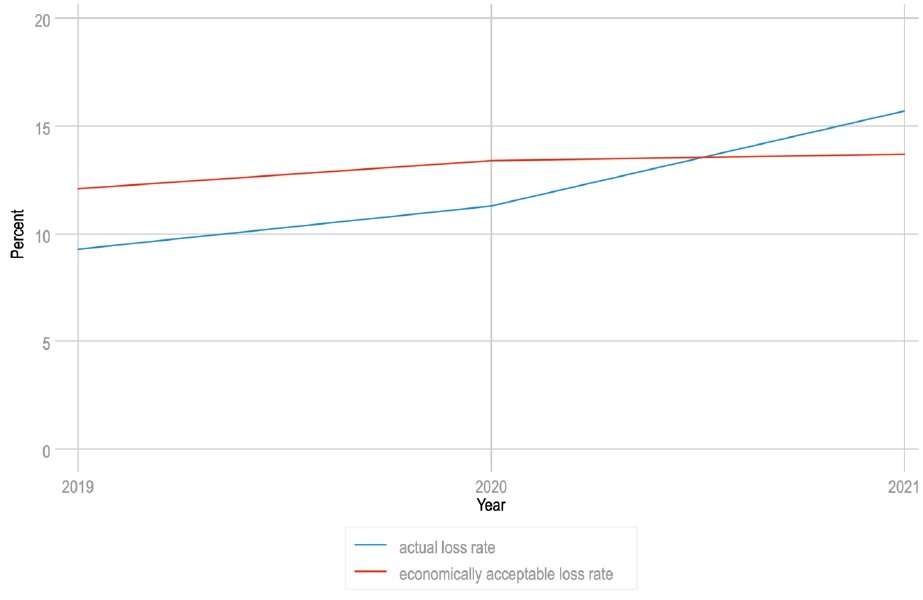
Figure 7. Trend in acceptable colony loss rate in comparison to reported colony loss rates between 2019 and 2021, for beekeepers with >250